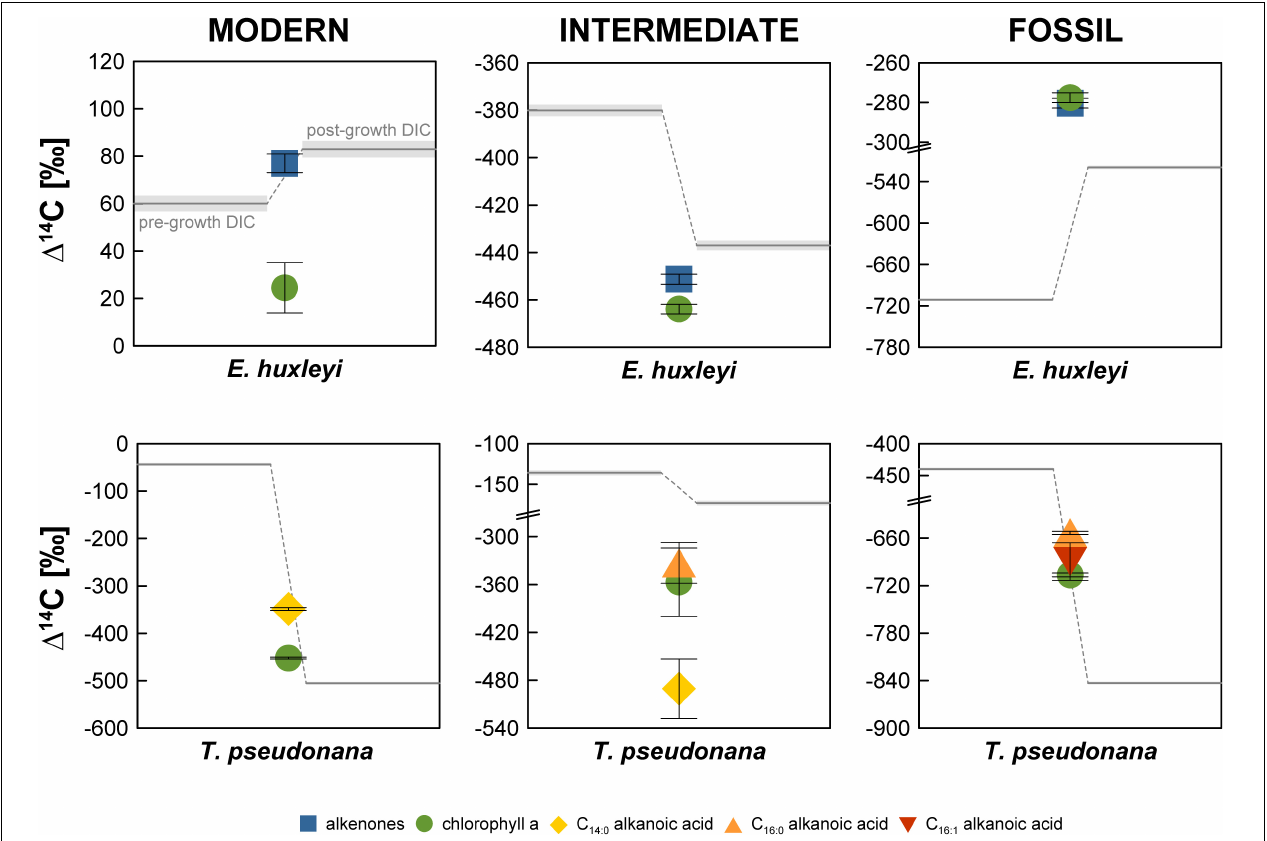
) of the Emiliania huxleyi and Thalassiosira pseudonana cultures. Errors bars (shaded area for DIC) (cid:104)